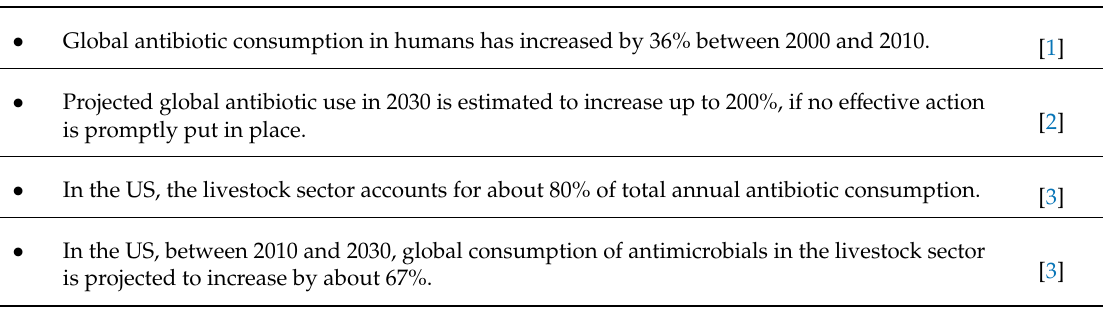
Table 1. Antimicrobial resistance, a major global threat: